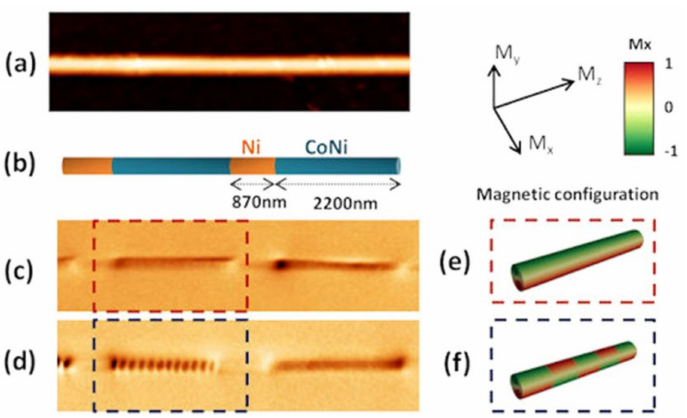
Figure 4. ( a ) Topography, ( b ) geometry sketch, and ( c , d ) MFM images of different nanowires. In ( c ), the segment in the red square shows a uniform magnetization, while in ( d ) a multidomain structure is displayed. Figures ( e , f ) schematically show the expected magnetization configurations corresponding to ( c , d ) MFM images, respectively. Reprinted from [54] and originally published under a CC-BY